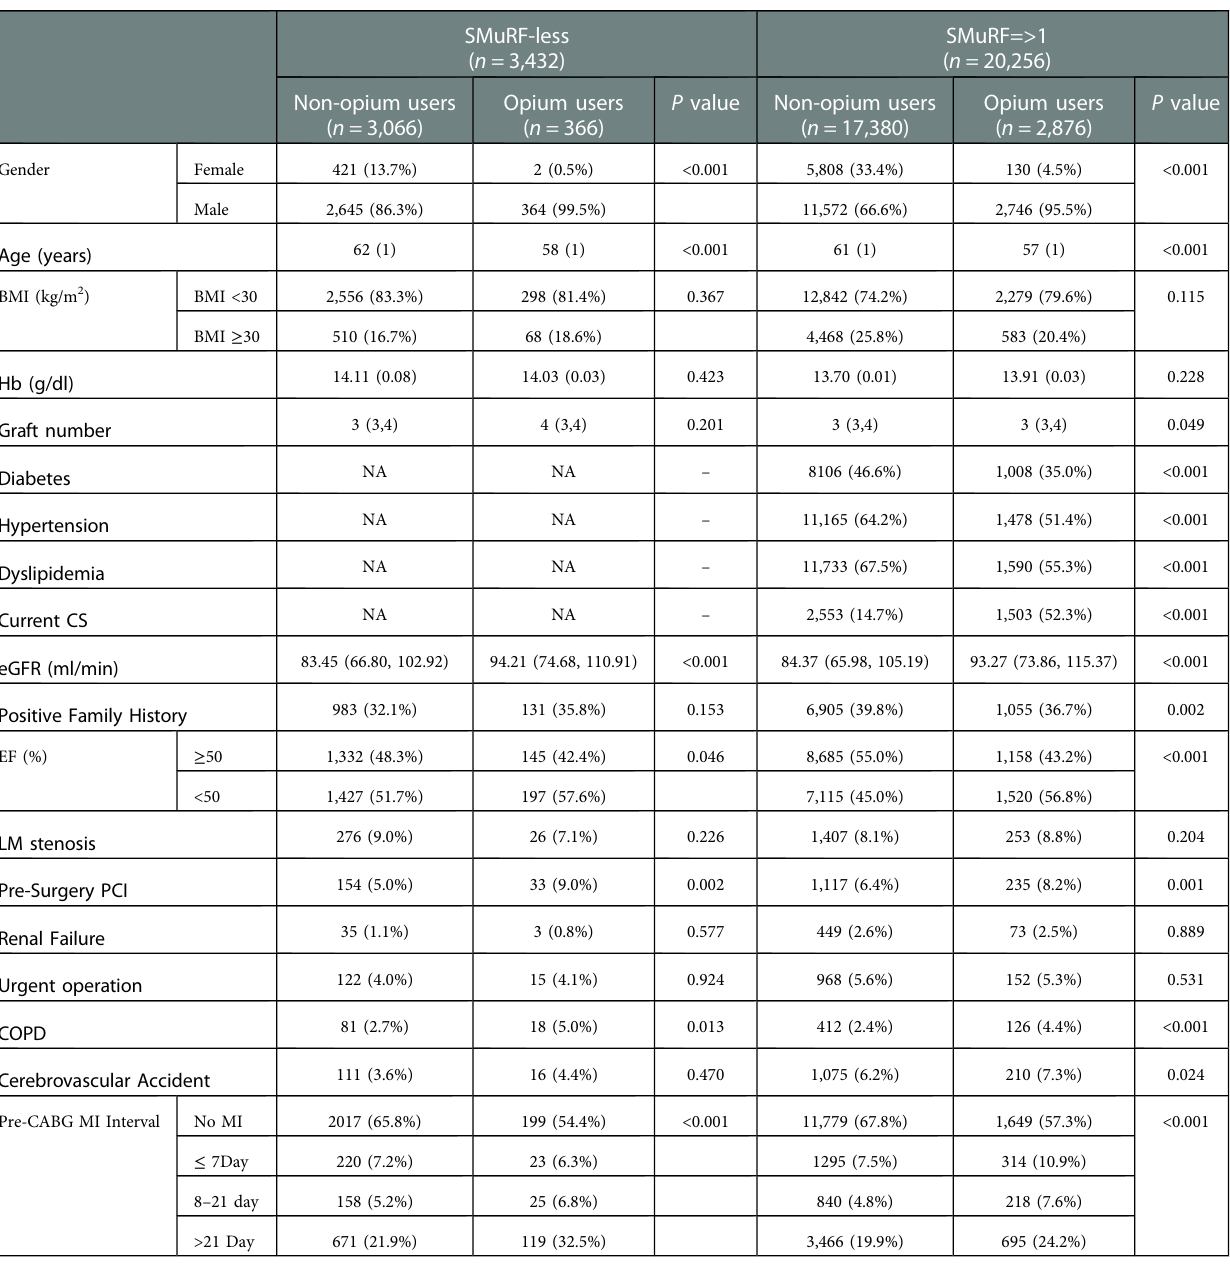
TABLE 1 Baseline characteristics based on the presence of SMuRFs and opium